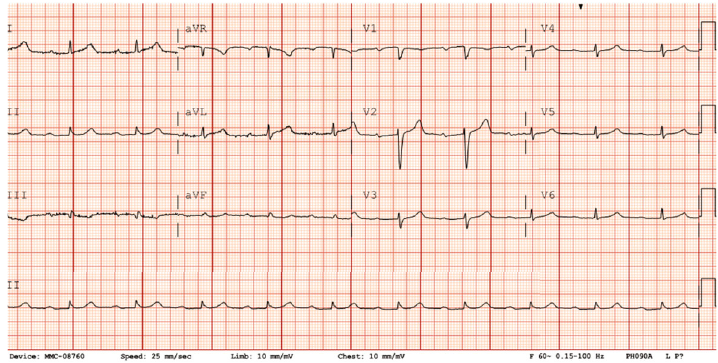
Figure 1: EKG on presentation showing sinus rhythm with prolonged PR interval.